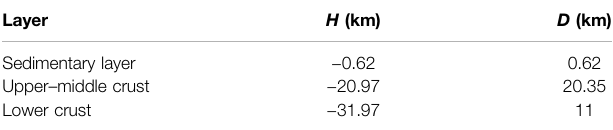
TABLE 5 | Geothermal structure in Jinggangshan